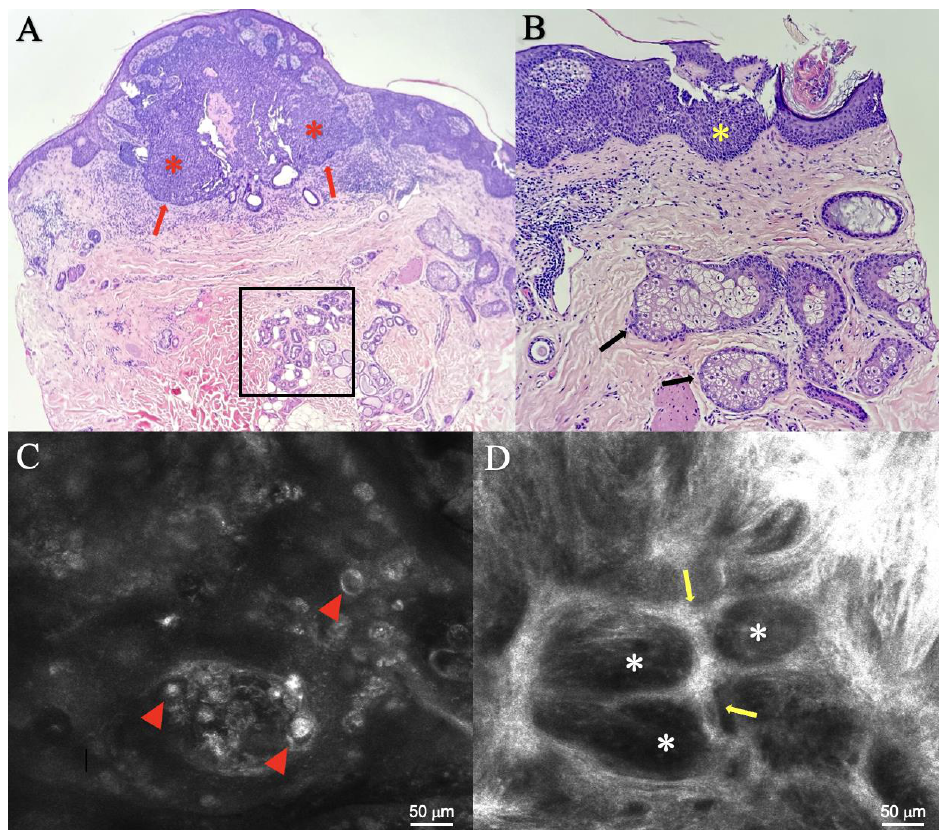
Figure 2. Histopathological and confocal microscopy images of the lesion. ( A ) A histopathological image showing nodular proliferation composed of islands of basaloid cells (red asterisks) with peripheral palisading (red arrows). Deep apocrine glands can also be seen (black square). ( B ) A close-up of the perilesional skin showing acanthosis (yellow asterisks) and sebaceous glands (black arrows). Hematoxylin-eosin stain, original magnification: ( A ) ×20; ( B ) ×40. ( C ) Confocal images showing large, monomorphic, hyperreflective cells with a hyperreflective center corresponding to sebocytes (red arrowheads). ( D ) Confocal microscopy image showing dark silhouettes corresponding to tumor islands (white asterisks) and hyperreflective collagen bundles surrounding tumor islands (yellow arrows).